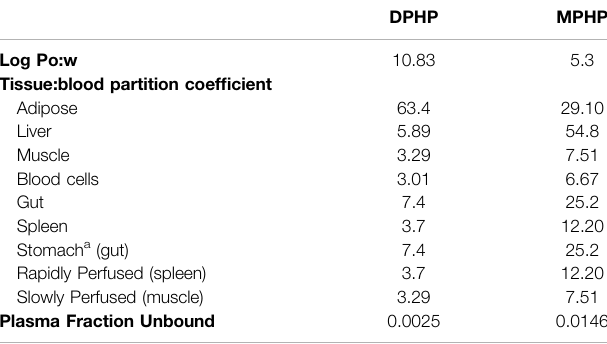
TABLE 1 | Tissue:blood partition coef fi cients and plasma fraction unbound predicted using Log P ow